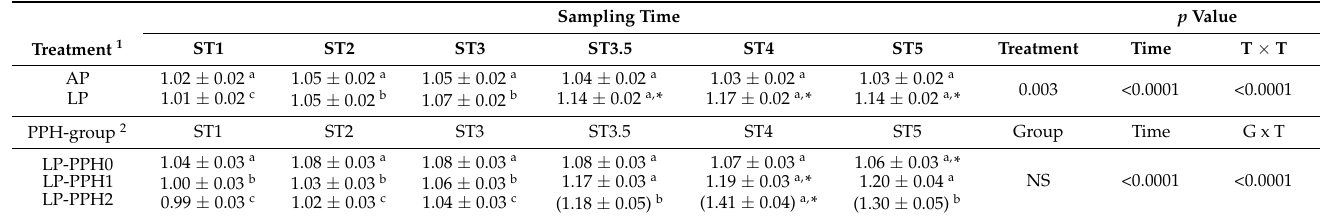
Table 3. Mean corpuscular hemoglobin (fmol) of periparturient dairy cattle receiving AP or LP diet. Sampling Time